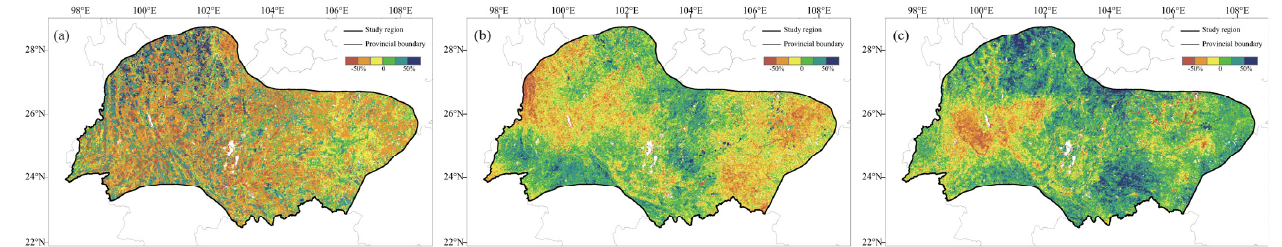
Figure 7. The spatial distributions of annual NPP anomaly percentage in 2010 ( a ), 1999 ( b ), and 2013 ( c ) relative to the average for the 2000–2009 period.